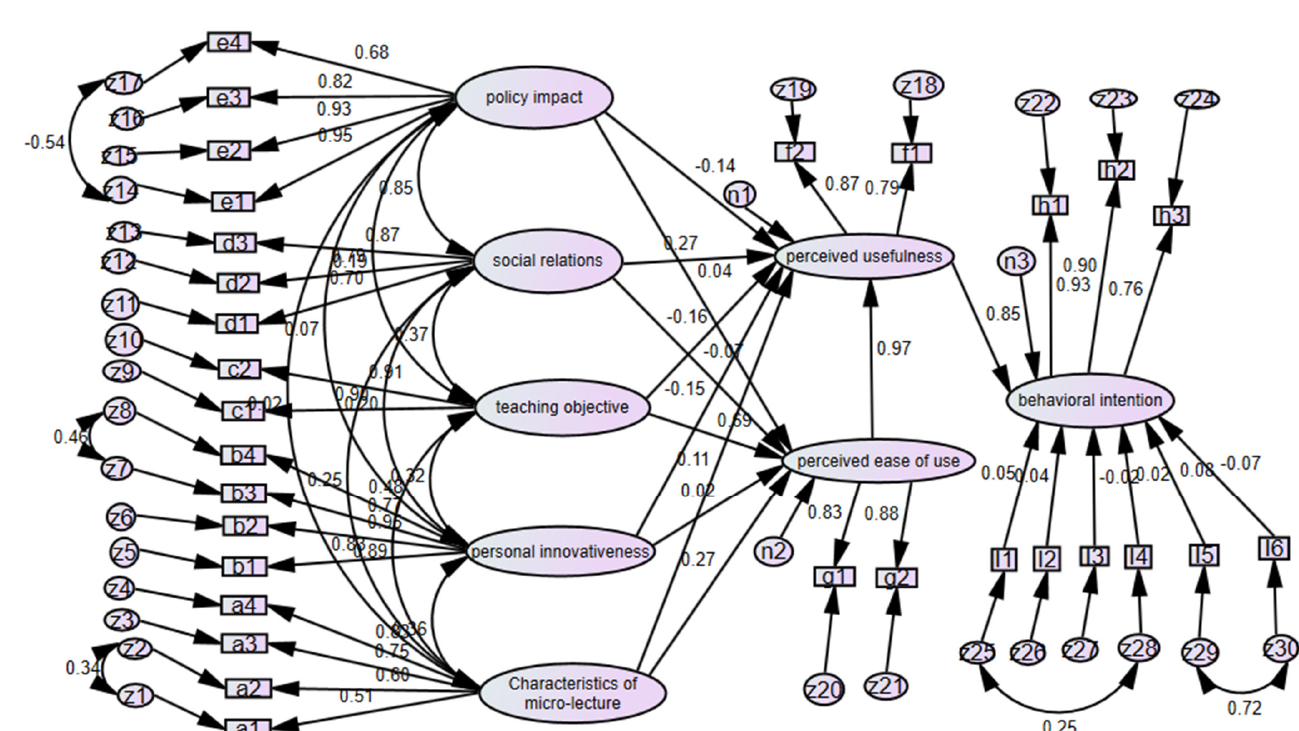
Figure 4. Validation of factors influencing university teachers’ intentions for using micro-lecture in the post COVID-19 era in AMOS.